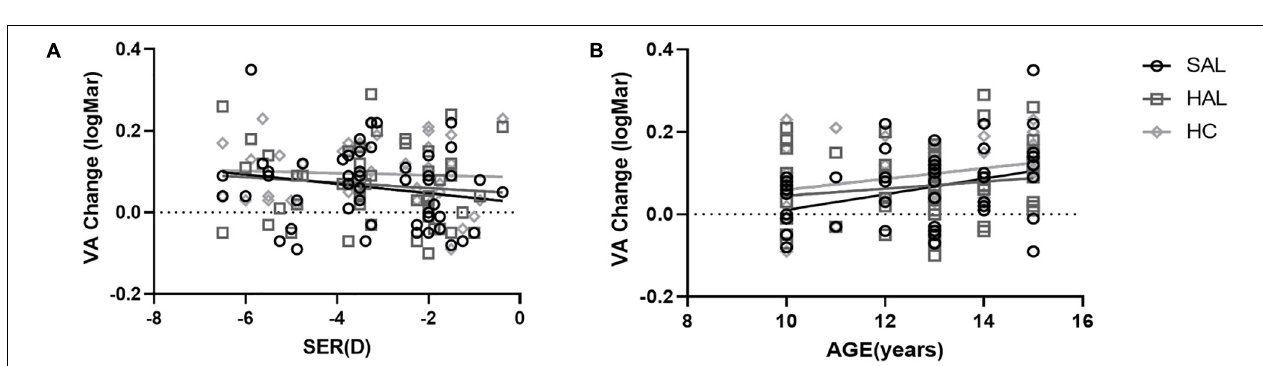
FIGURE 7 | (A) Mean visual acuity (VA) with standard errors of four lenses (SVL for single-vision lens, HAL for spectacle lenses with concentric rings of highly aspherical lenslets, SAL for spectacle lenses with concentric rings of slightly aspherical lenslets, and HC for lenses with spherical lenslets in honeycomb configuration) and (B) relative VA changes from SVL of three lenses with lenslets in logMAR unit. N = 50. Asterisk (*) and number sign (#) represent significance in the Bonferroni post hoc test following the repeated measures ANOVA. ** p < 0.01, comparisons of each of the three lenses with lenslets to SVL; # p < 0.05, ## p < 0.01, comparisons between each pair of the three lenses with lenslets.